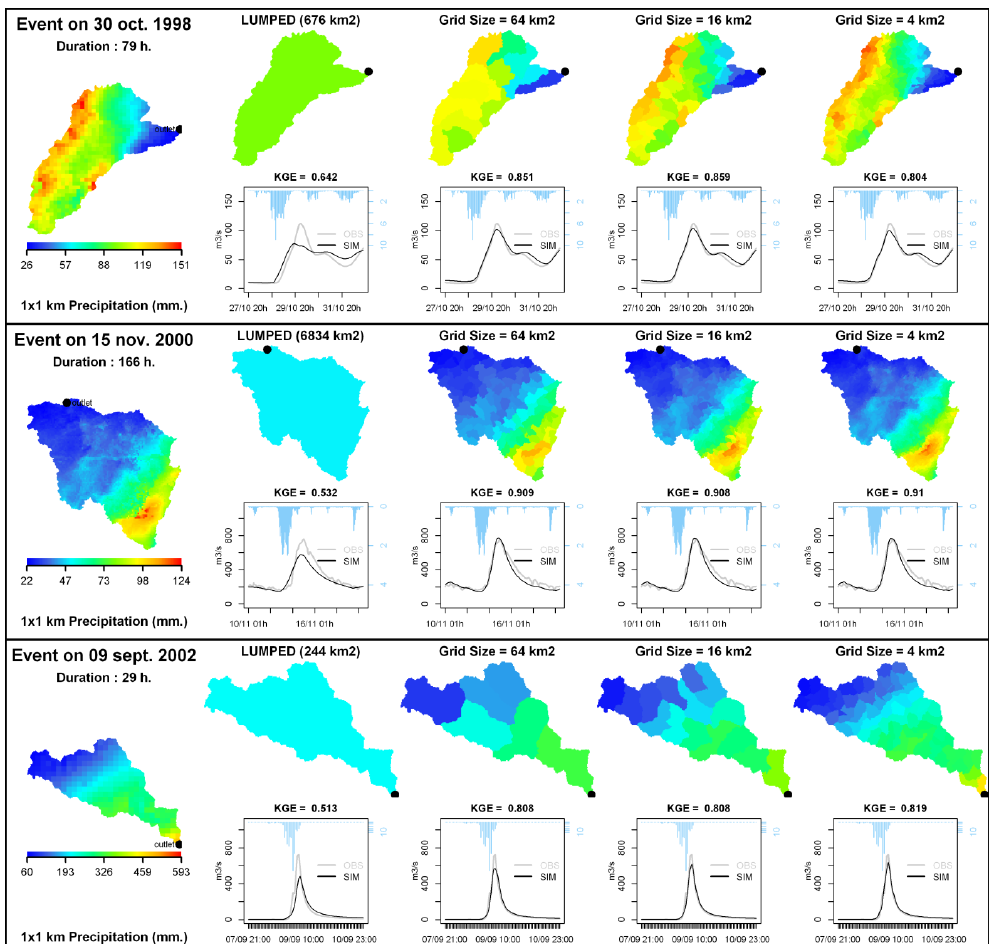
Fig. 15. Cumulated precipitation fields (with extreme location index values) observed for three flood events with simulated and observed streamflow at different spatial resolutions: October 1998 flood event ( I L =1.07 and I σ =2.00) in the Bruche catchment at Holtzheim (676km 2 ) (top panels); November 2000 flood event ( I L =1.12 and I σ =1.17) in the Moselle catchment at Custines (6834km 2 ) (middle panels); September 2002 flood event ( I L =0.85 and I σ =13.47) in the Gardon catchment at Mialet (244km 2 ) (bottom).